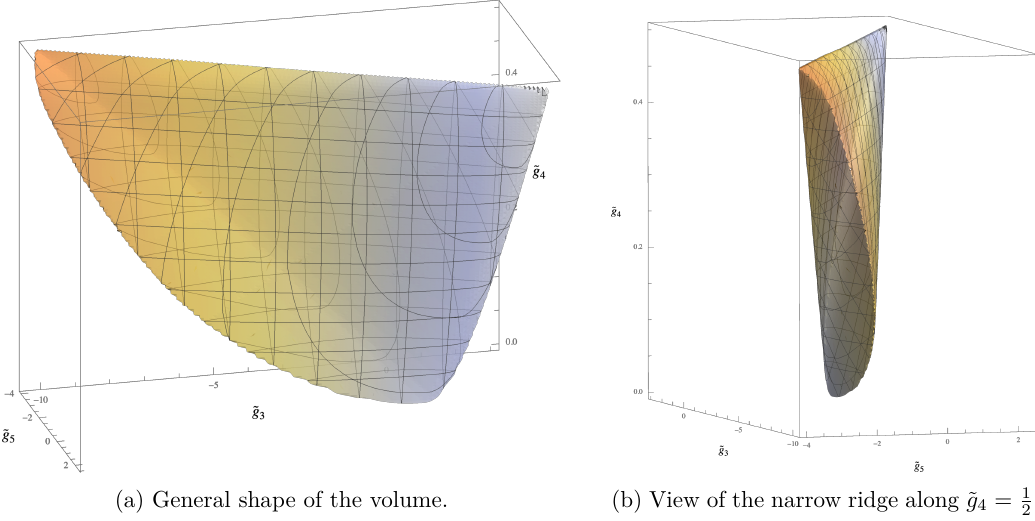
Figure 11. ˜ g 3 vs. ˜ g 4 vs. ˜ g 5 “tortilla chip”. Numerics were performed at n = 10 Mandelstam order and J = 0 , 2 , . . . , 40 . The volume is surprisingly narrow, showing a strong ˜ g